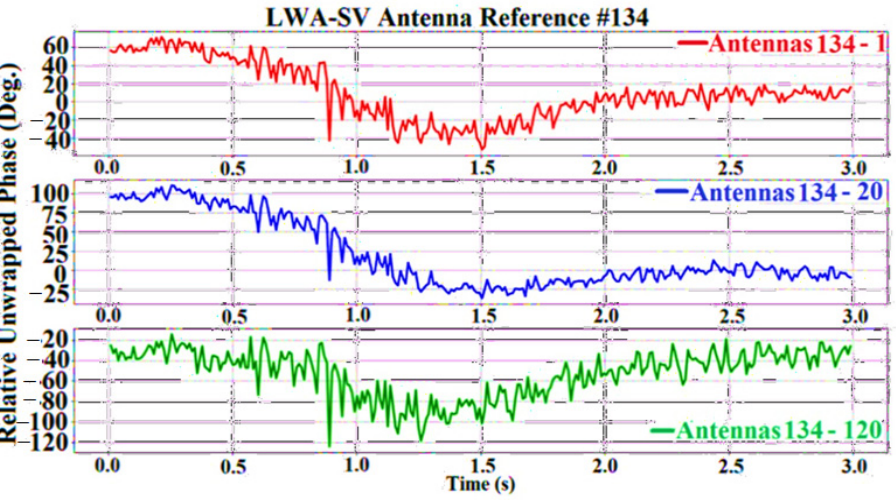
Figure 7. The graphic shows an example of relative unwrapped phases vs. time in 3 s for LWA-SV.